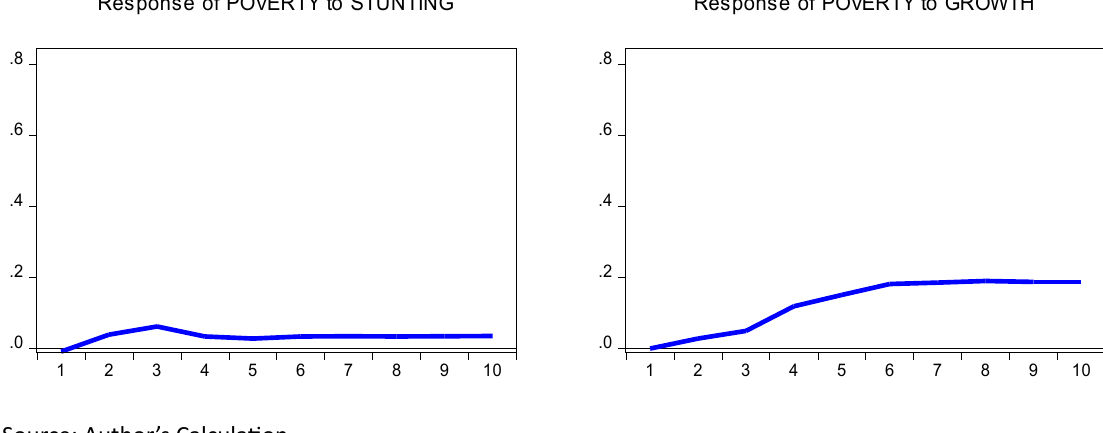
Figure 8: Impulse Response Function Poverty Due to Shock Prevalence of Stunting and Economic Growth